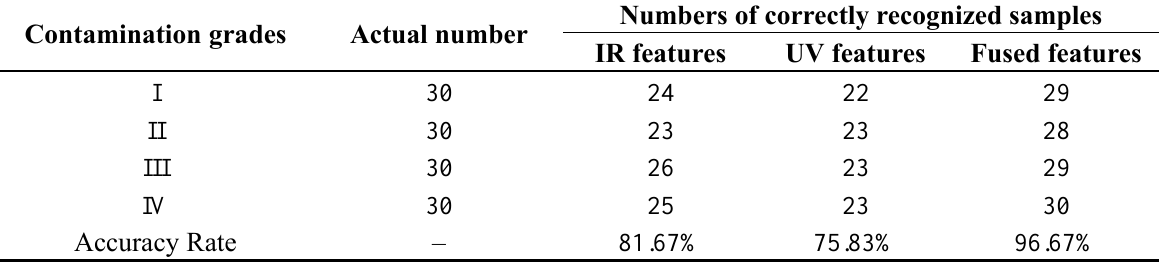
Table 1. Results of contamination grades